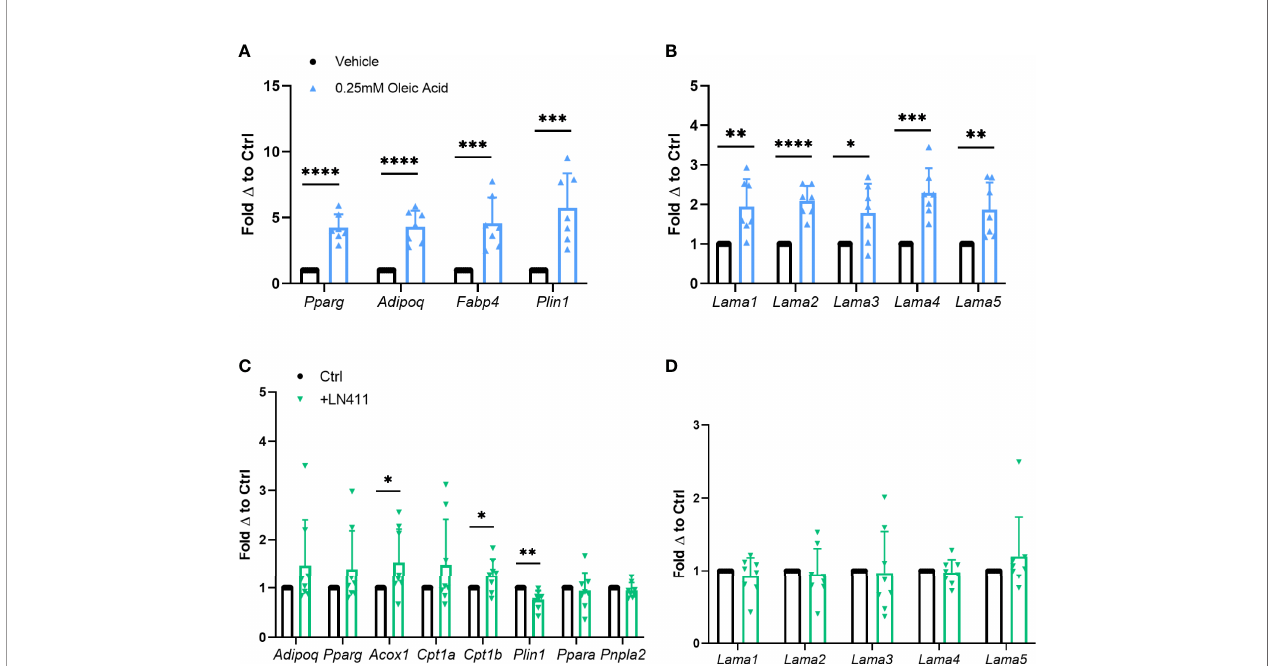
FIGURE 3 | Relationship of Lama4 to lipid storage and metabolism in vitro . (A) Gene expression of adipogenic markers in primary murine pre-adipocytes treated with vehicle or 0.25mM Oleic Acid during differentiation. Vehicle (n=7), Oleic Acid (n=7). (*,**,***,****) indicates p < 0.05, 0.01, 0.001, 0.0001 respectively. Data are Means ± SD. (B) Laminin- a chain gene expression in primary differentiated murine adipocytes treated with vehicle or 0.25mM Oleic Acid during differentiation. Vehicle (n=7), Oleic Acid (n=7). (C) Expression of genes involved in lipid metabolism, oxidation, and adipogenesis in primary murine differentiated adipocytes grown on culture plates coated with 0ug (n=8) or 10ug of LN411 (n=8). (D) Laminin- a chain gene expression in primary murine differentiated adipocytes grown on culture plates coated with 0ug (n=8) or 10ug of LN411